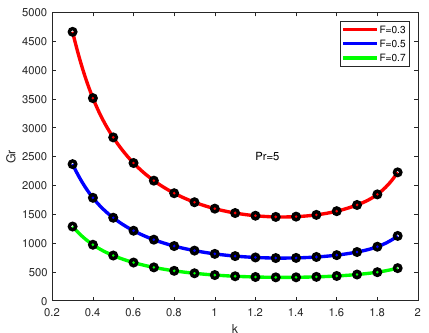
Figure 12. Marginal stability curves for Pr = 5 (Case 2).